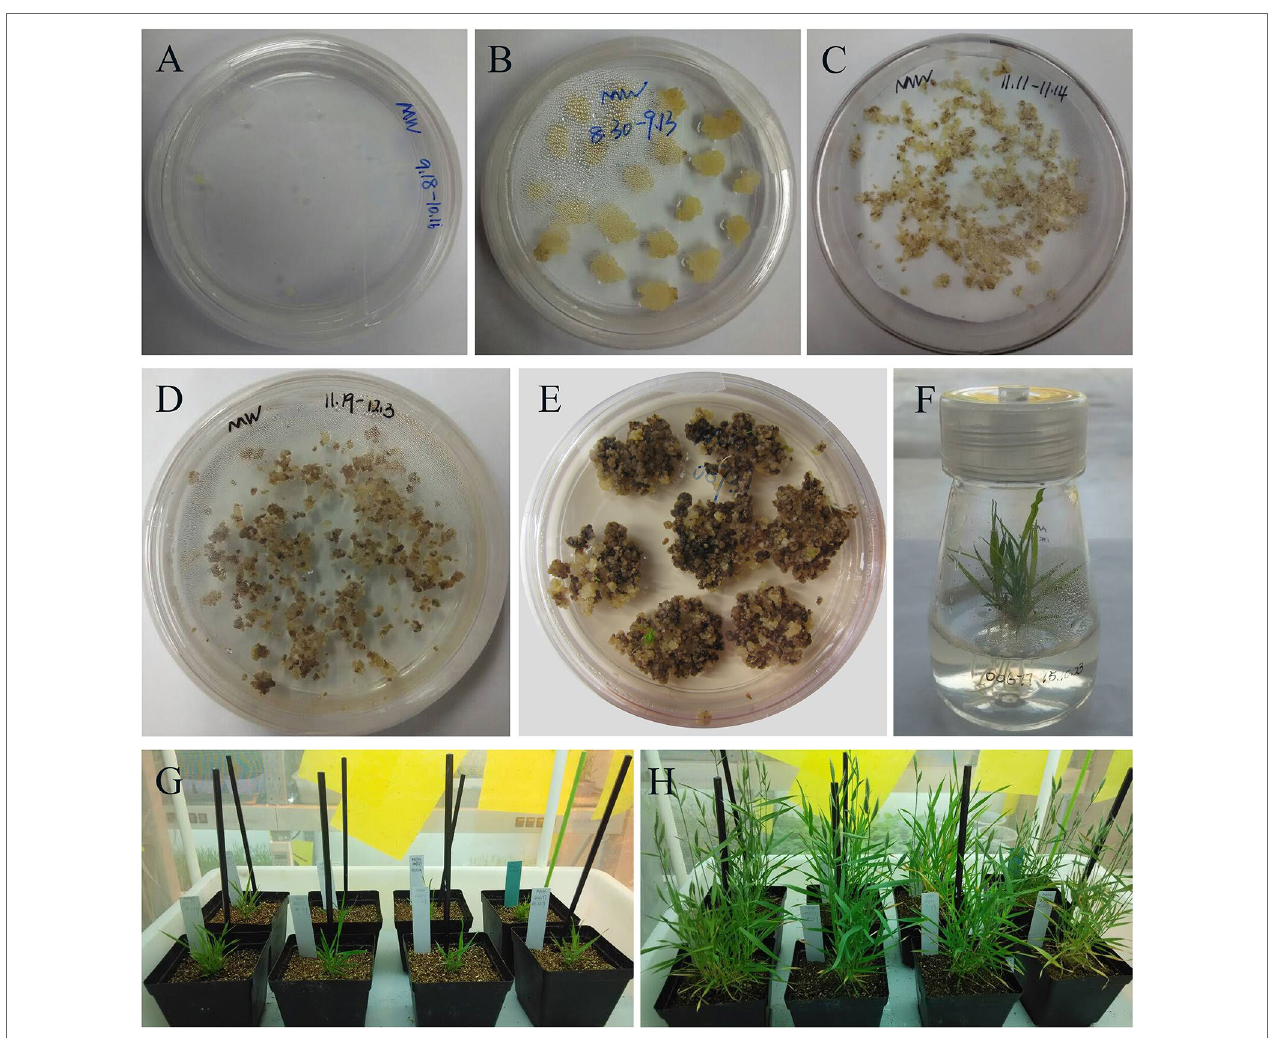
FIGURE 3 | Stable genetic transformation of B. distachyon (genotype Bd21-3). (a) Immature embryos grown on callus induction medium; (B) embryo after 3 weeks on callus induction medium; (C) co-cultivation compact embryogenic callus with Agrobacterium on filter paper; (D) co-cultured compact embryogenic callus on selection medium; (E) regenerating callus on regeneration medium; (F) rooted putative transformants on rooting medium; putative transformant grown in soil for 2 weeks (G) and 8 weeks (H) ,